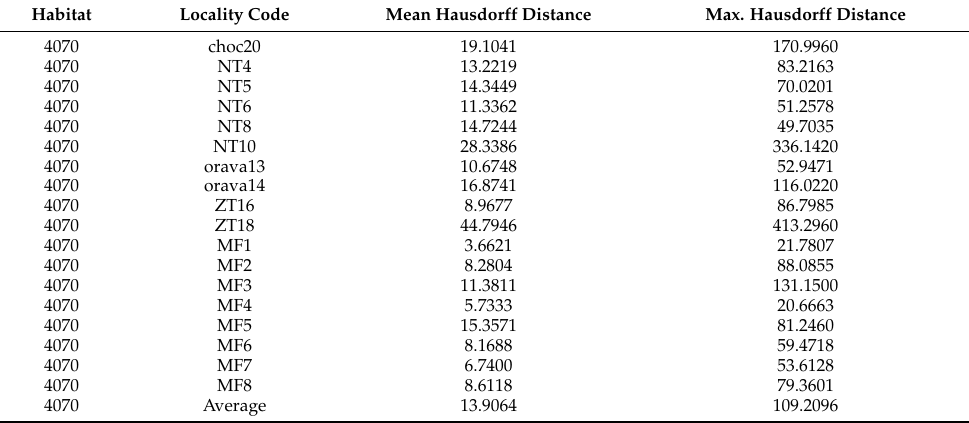
Figure 6. The locality with the highest maximal Hausdorff distance between semi-automatically segmented and GPS-tracked curves among sites with Pinus mugo (ZT 18). On the north-west habitat border, we can observe the “ecotone zone” that was included during field tracking (blue) and excluded by using of the semi-automatic segmentation (light-blue). Table 3. The list of 4070 * bushes with Pinus mugo localities with the mean and maximal Hausdorff distances of semi-automatically segmented and GPS-tracked area